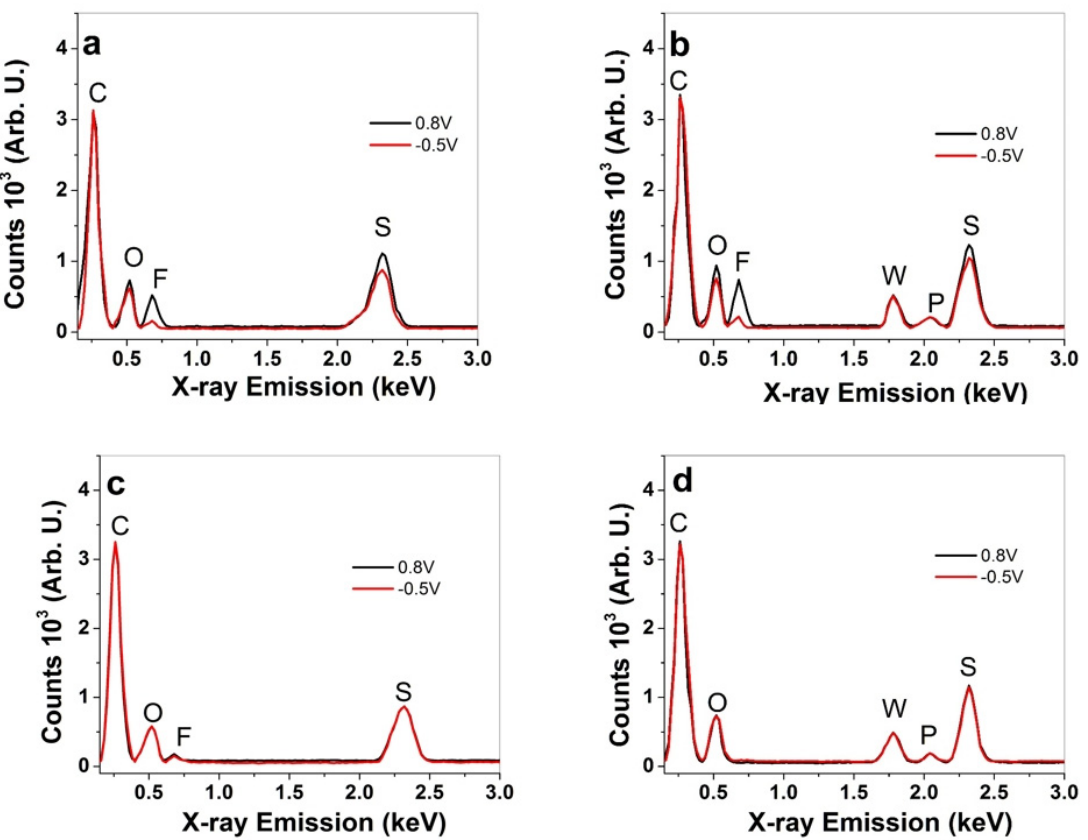
Figure 3. EDX spectroscopy of the counts against X-ray emission at oxidation (0.8 V, black line) and reduction ( − 0.5 V, red line) performed after the actuation cycles: cross-section image in LiTFSI-PC showing the ( a ) PPyCDC and ( b ) PPyCDC-PT samples. The spectra in the LiTFSI-aq electrolyte are presented for ( c ) PPyCDC and ( d ) PPyCDC-PT.